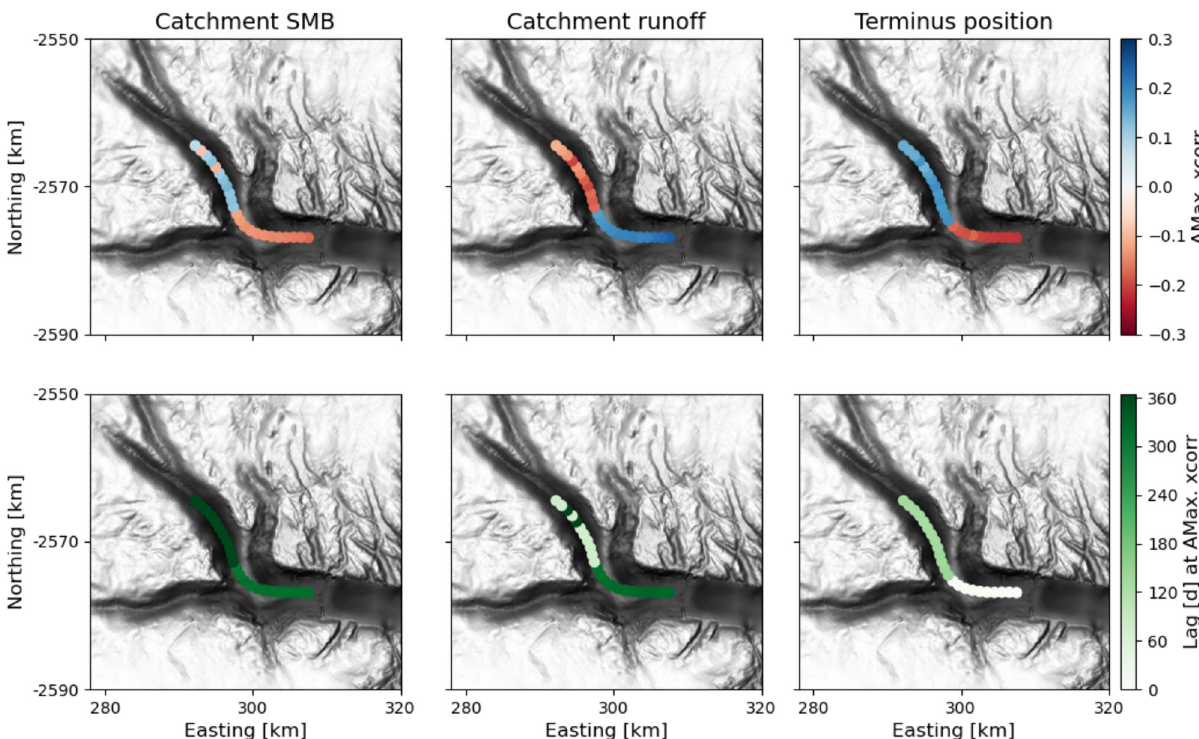
Fig. 2 | The cross-correlation of largest absolute value ( “ AMax. xcorr ” ) (top row) between ice surface speed and each variable (columns), and the lag in days (bottom row) at which that cross-correlation is found. Circles indicate